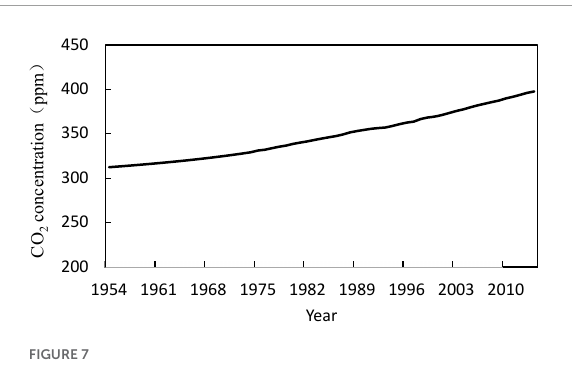
FIGURE7 Changes of CO 2 concentration since 1954 in the Sanjiang Plain.